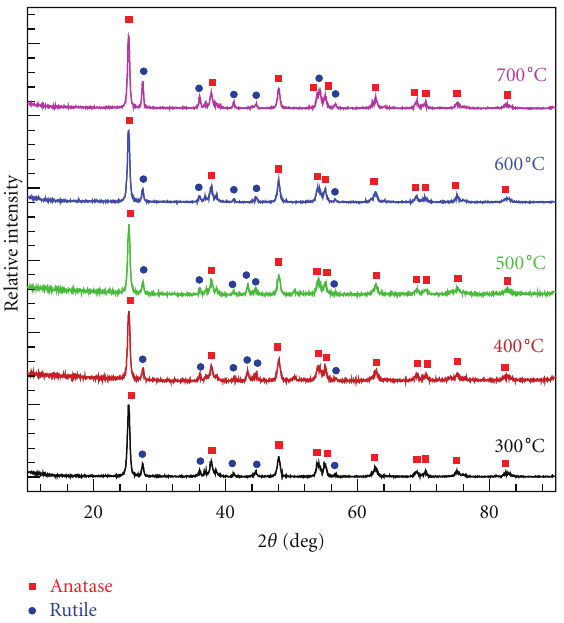
Figure 9: XRD patterns of the TiO 2 -deposited film sintered at di ff erent